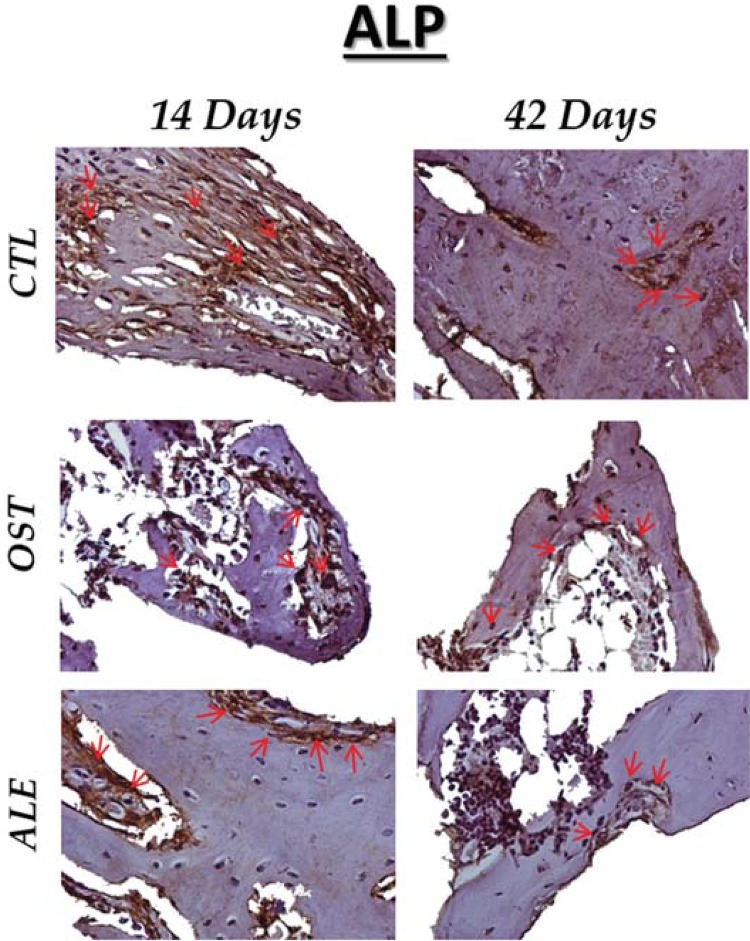
ALP immunostaining at 14 days for the experimental groups (CTL: moderate; OST: light; ALE: moderate). At 42 days (CTL: moderate; OST: light; ALE: light). Immunolabeling indicated by red arrows. (Original, 40x)